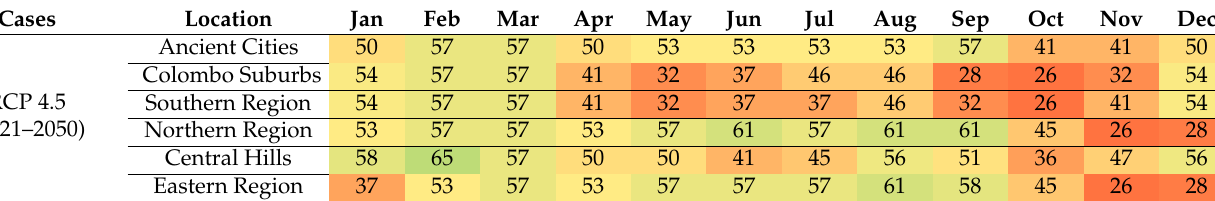
Table A4. HCI urban scores for considered